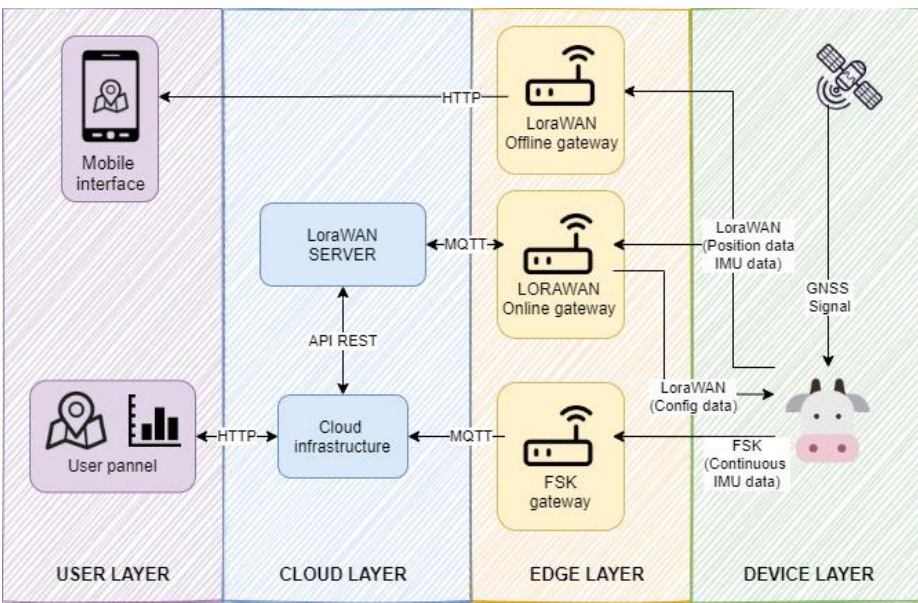
Figure 6. System infrastructure and communication flow.